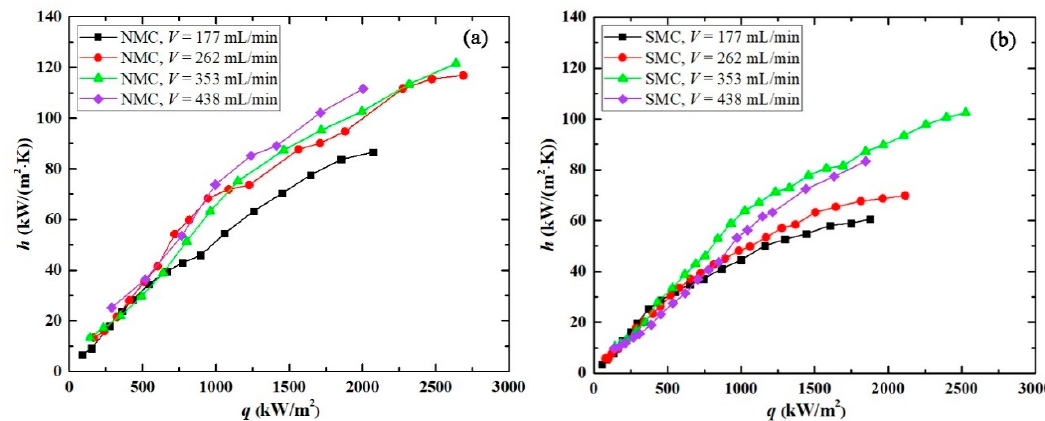
Figure 8. HTC for ( a ) NMC and ( b ) SMC.